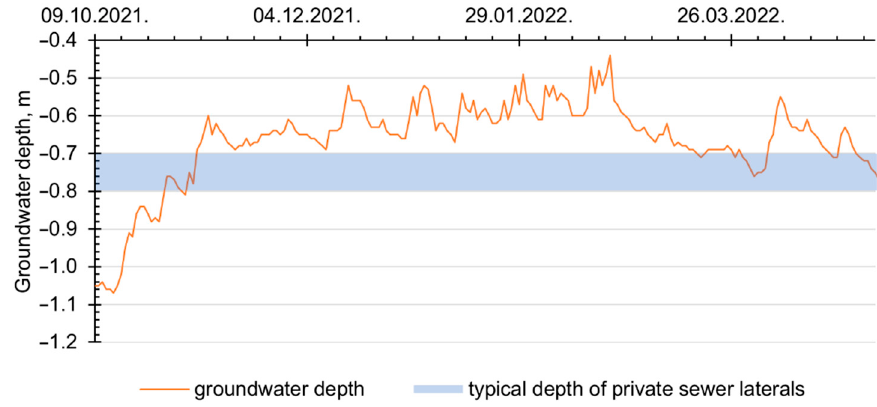
Figure 3. GWD variation during the study period.